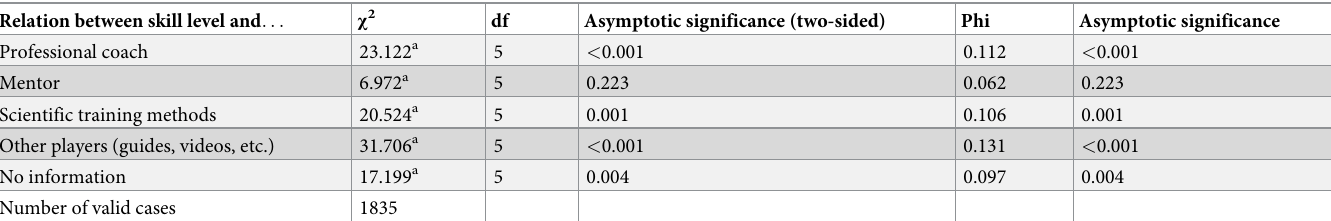
Table 21. Relation between skill level and professional coach, mentor, scientific training methods, other players and no information search. Relation between skill level and